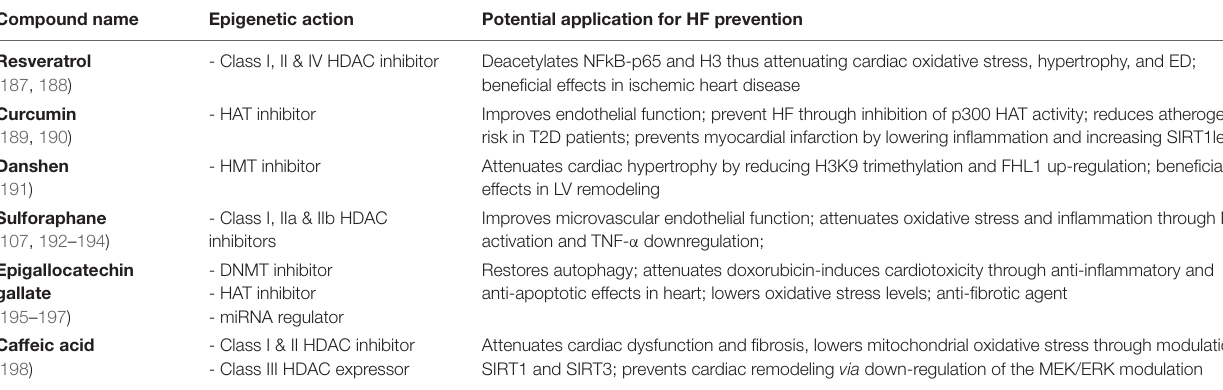
TABLE 2 | Natural compounds with known epigenetic effects and potential use in